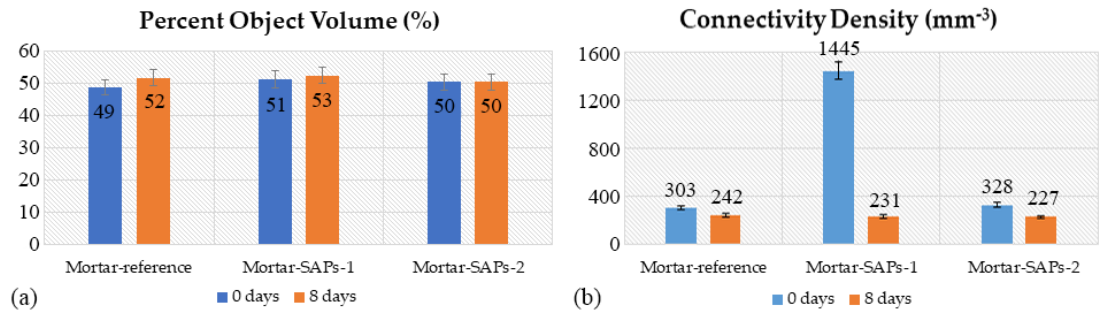
Figure 12. Calculated morphometric parameters to evaluate the self-healing process of mortars. Percent object volume ( a ), connectivity density ( b ). The error bars refer to percent error.